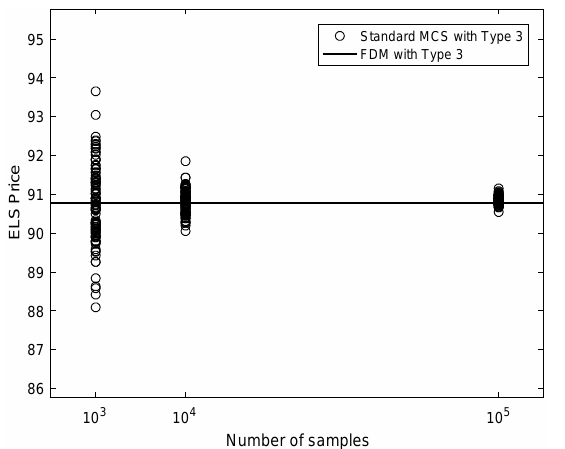
Figure 8. Type 3 ELS price versus the number of samples. Here, we plot 100 simulation results for each